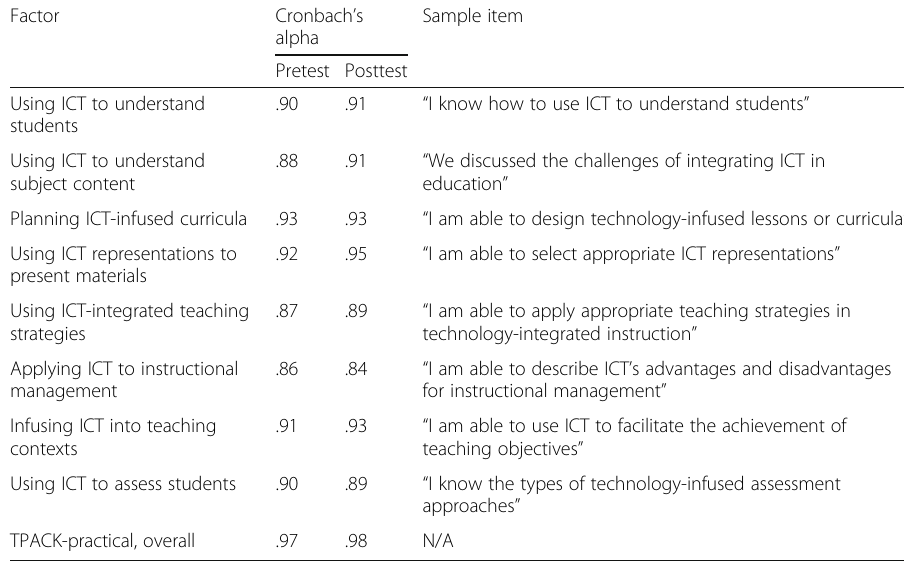
Table 2 TPACK-practical Scale Sample Items Factor Cronbach ’ s